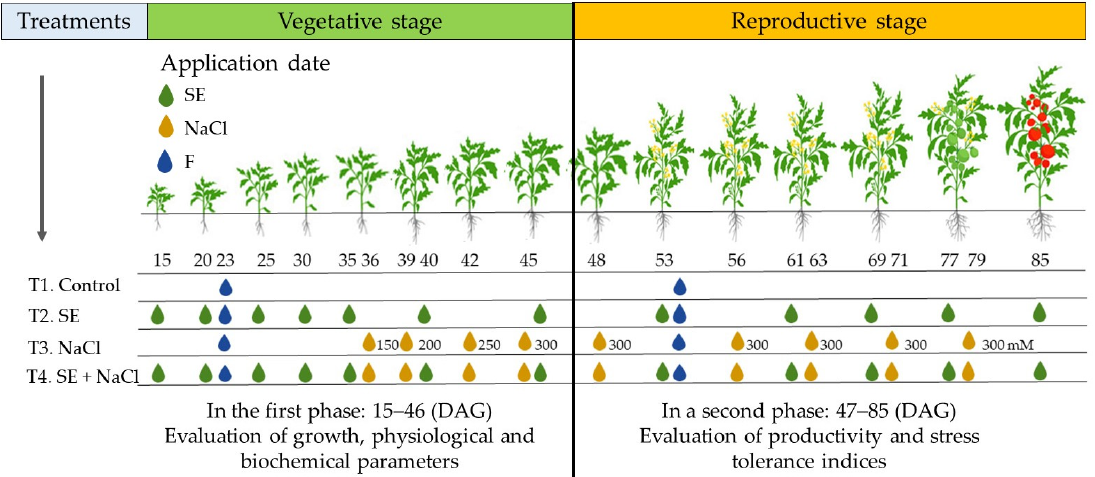
Figure 1. Schematic representation of phases one and two of the experiment. Each treatment is graphically represented by its own timeline. The vertical line in the middle of the timelines separates phase one from phase two. The ages of the plants are given in days after germination (DAG) that appear above the timelines directly below the plant icons. The application days of the seaweed extract (SE) from Padina gymnospora , sodium chloride (NaCl), and soluble fertilizer (F) are represented by the colored drops along each timeline and are given in terms of plant age (DAG). The NaCl concentration is shown next to each orange drop icon and is the same for each application day for treatments 3 and 4.